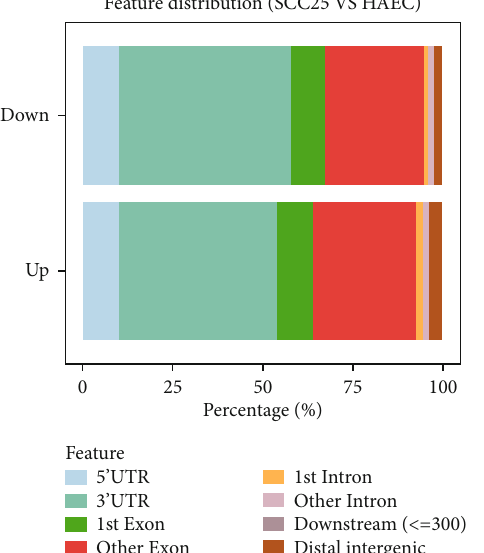
Figure 5: Functional area peak distribution. Metagene pro fi le demonstrated the m 6 A allocation in 5 ′ UTR, CDS, stop codon, and 3 ′ UTR. After the calculation of the peak distribution in the functional area covered by the peak annotation analysis results, the R software package ChIPseeker was applied to plot the statistical results into a histogram where all samples were compared together and plot each sample into a pie chart for separate viewing. In the histogram, the ordinate represented the sample, and the abscissa stood for the ratio of peaks in each functional area. The pie chart exhibited the exact percentage of peaks in each functional area. 5 ′ UTR: the ratio of peaks falling within the 5 ′ UTR; 3 ′ UTR: the ratio of peaks falling within the 3 ′ UTR; 1st exon: the ratio of peaks falling within the fi rst exon of the transcript; other exon: the ratio of peaks falling within other exons except for the fi rst exon of the transcript; 1st intron: the ratio of peaks falling within the fi rst intron of the transcript; other intron: the ratio of peaks falling within other introns except for the fi rst intron of the transcript; distal intergenic: the ratio of peaks falling in the intergenic